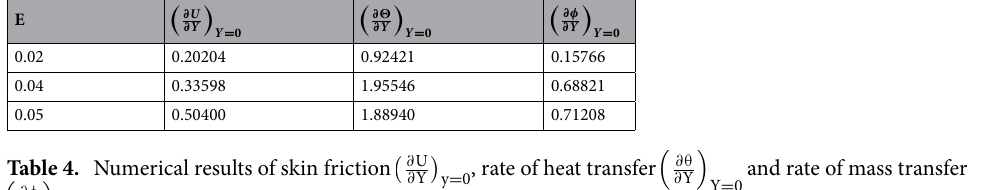
Table 4. Numerical results of skin